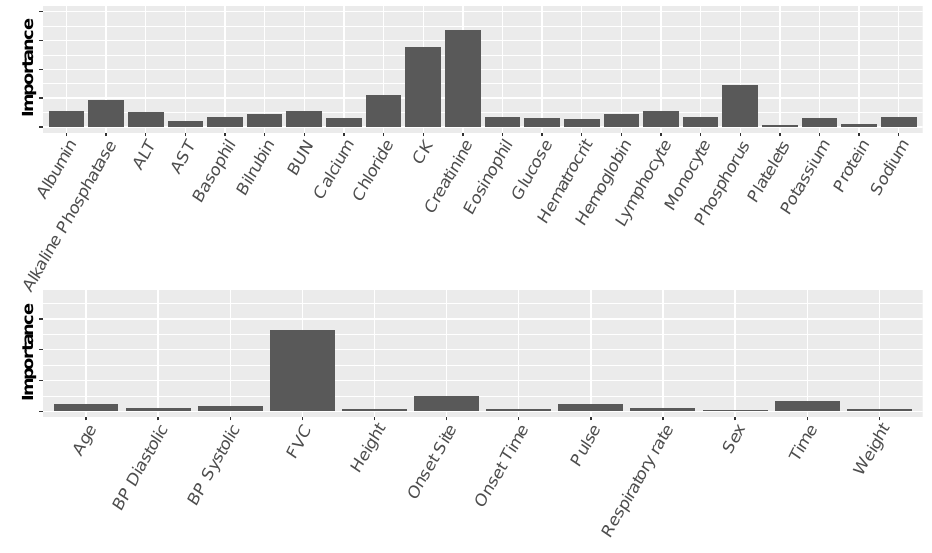
Figure 5. Average predictor importance for laboratory test variables ( top ) and non-laboratory test variables ( bottom ). “Time” measures the time values were documented from the beginning of a clinical trial. BP represents blood